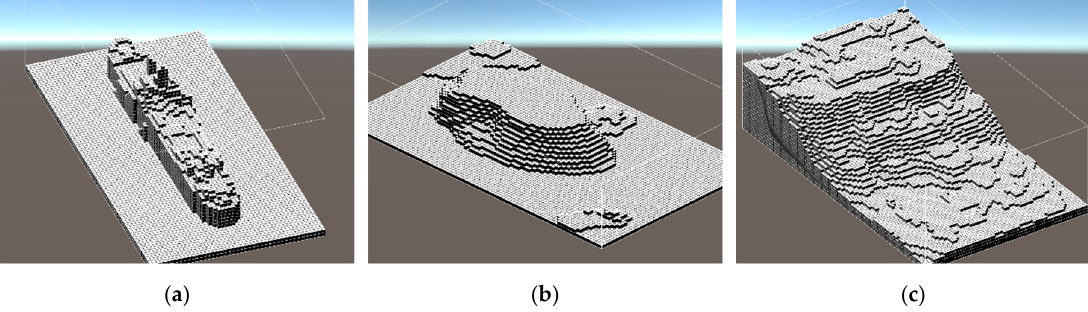
Figure 7. The 3D grids of each underwater site: ( a ) the shipwreck, ( b ) the seamount, and ( c ) the landslide.